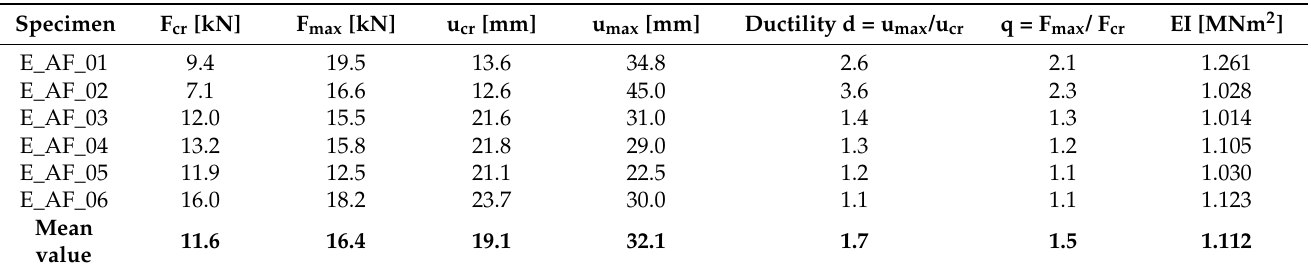
Table 9. Results of measurements and of bending stiffnesses of TGIB-gw with annealed float glass—